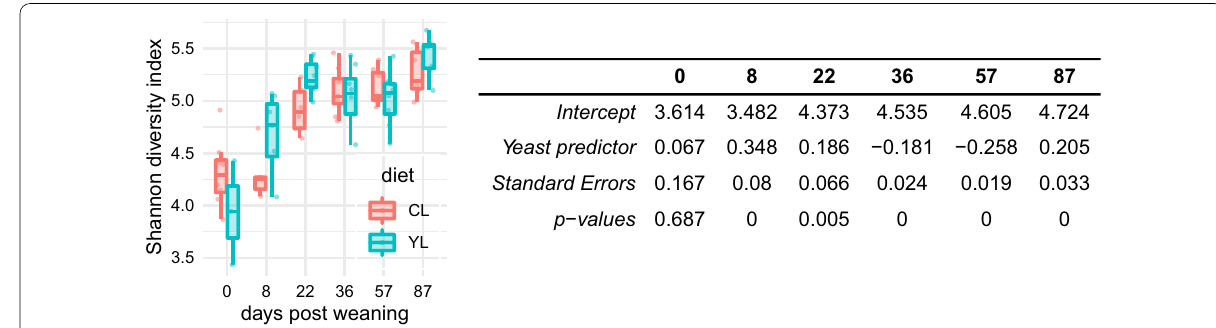
Fig. 2 Alpha microbial diversity. Left Distributions of the observed values of Shannon diversity index. Right The summary of the statistical inference for the alpha diversity measured by Shannon diversity index. The’intercept’ terms are the inferred estimates of the control group (CL) Shannon indices across d0–d87 PW. The’Yeast predictor’ terms are the inferred estimates of the yeast group (YL) Shannon indices across d0–d87 PW